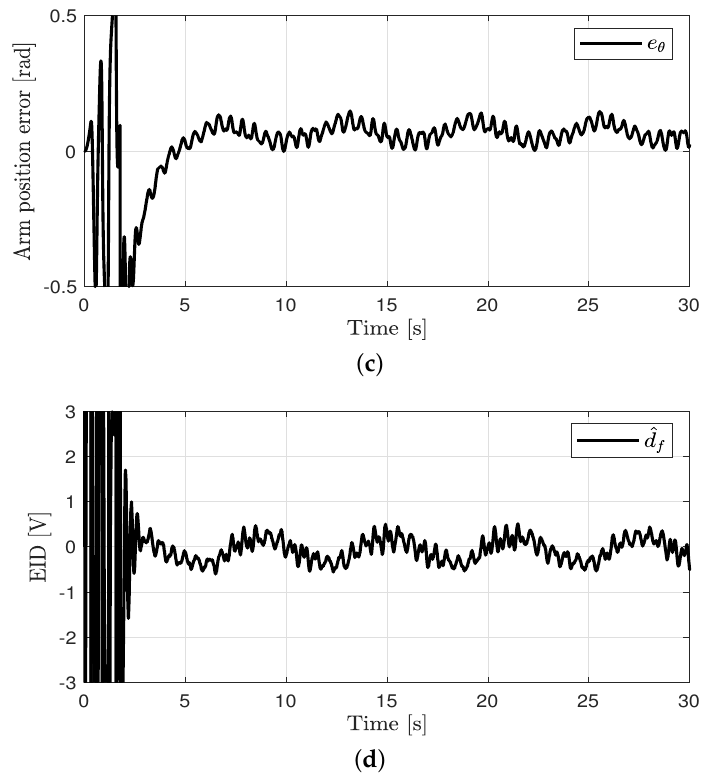
Figure 5. Control performance in case 3. ( a ) Arm position (case 3). ( b ) Pendulum pole position (case 3). ( c ) Arm position error (case 3). ( d ) Estimated EID (case 3).